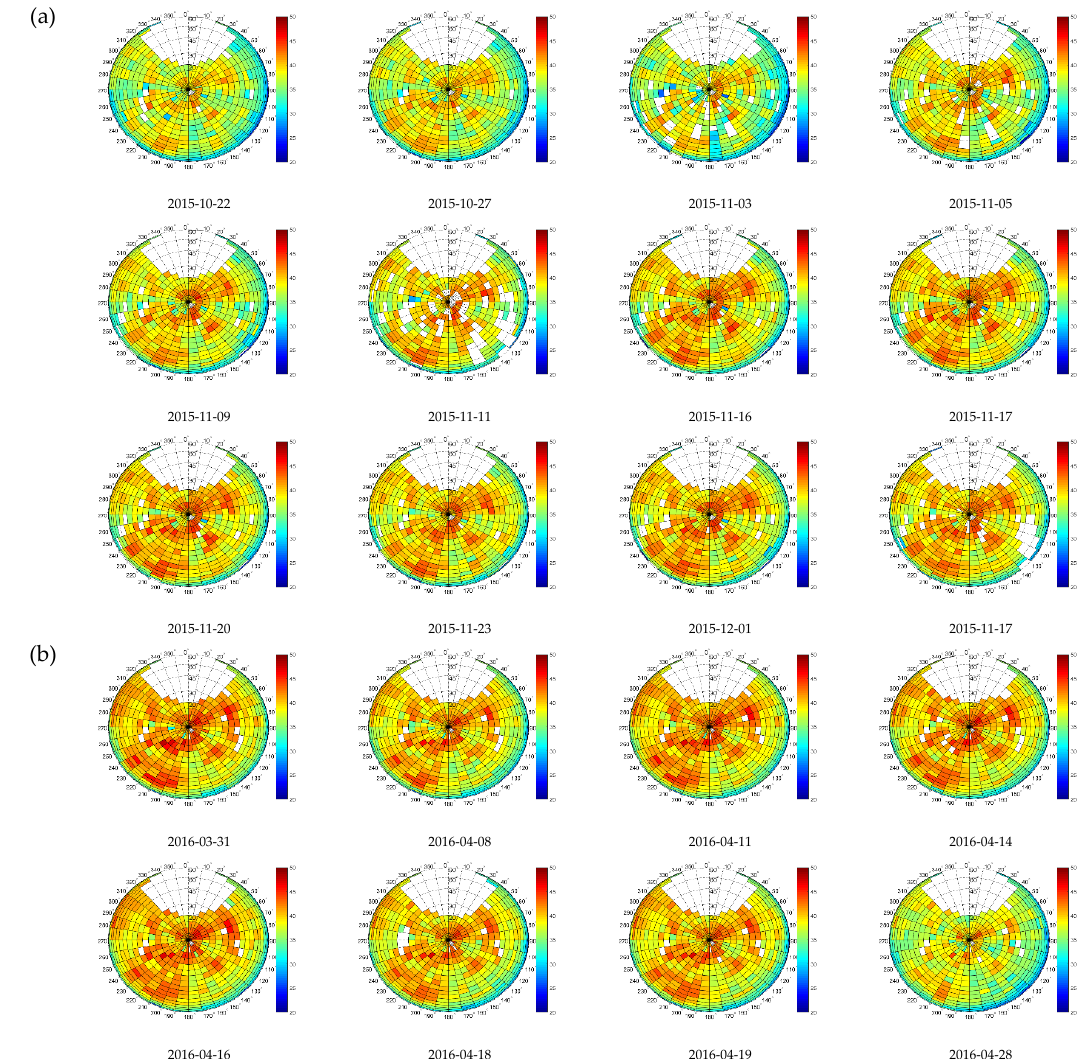
Figure 6. RHCP received C / N 0 during the ( a ) fall; and ( b ) spring season for di ff erent dates when vegetation pictures were taken. Incidence angle in 5 ° steps, azimuth angle in 10 ° steps.